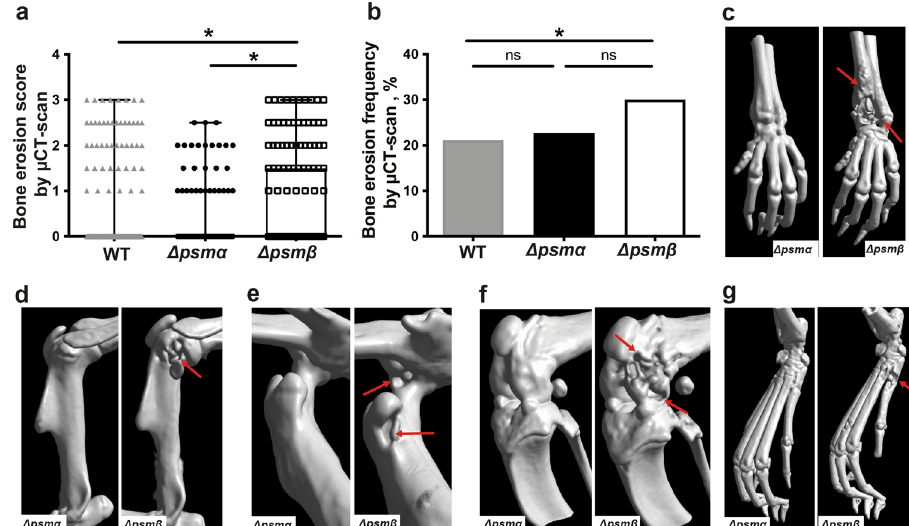
Fig. 5 PSM β de fi cient mutant strain causes more severe joint destruction. NMRI mice ( n = 11 – 21/group) were intravenously injected with S. aureus Newman (wild type, WT), or the isogenic mutant strains Δ psm α and Δ psm β (5 × 10 6 CFU/mouse) and sacri fi ced on day 10 post-infection. Shown is the accumulative bone destruction scores a and frequency of bone destructions b of the joints from all 4 limbs of mice as assessed by micro computed tomography ( µ CT) scan. Representative µ CT scan images c – g showing both intact (left) and heavily eroded (right) joints, c wrists, d shoulders, e hips, f knees and g hind paws. Arrows indicate the bone erosion. The results from three independent experiments were pooled. The data are reported as mean ± standard error of the mean and analyzed with the Mann-Whitney U test, with data expressed as box plots showing interquartile range, and whiskers showing minimum and maximum a or Fisher ’ s exact test b . * P < 0.05; ns not signi fi cant. COMMUNICATIONS BIOLOGY| (2022) 5:910